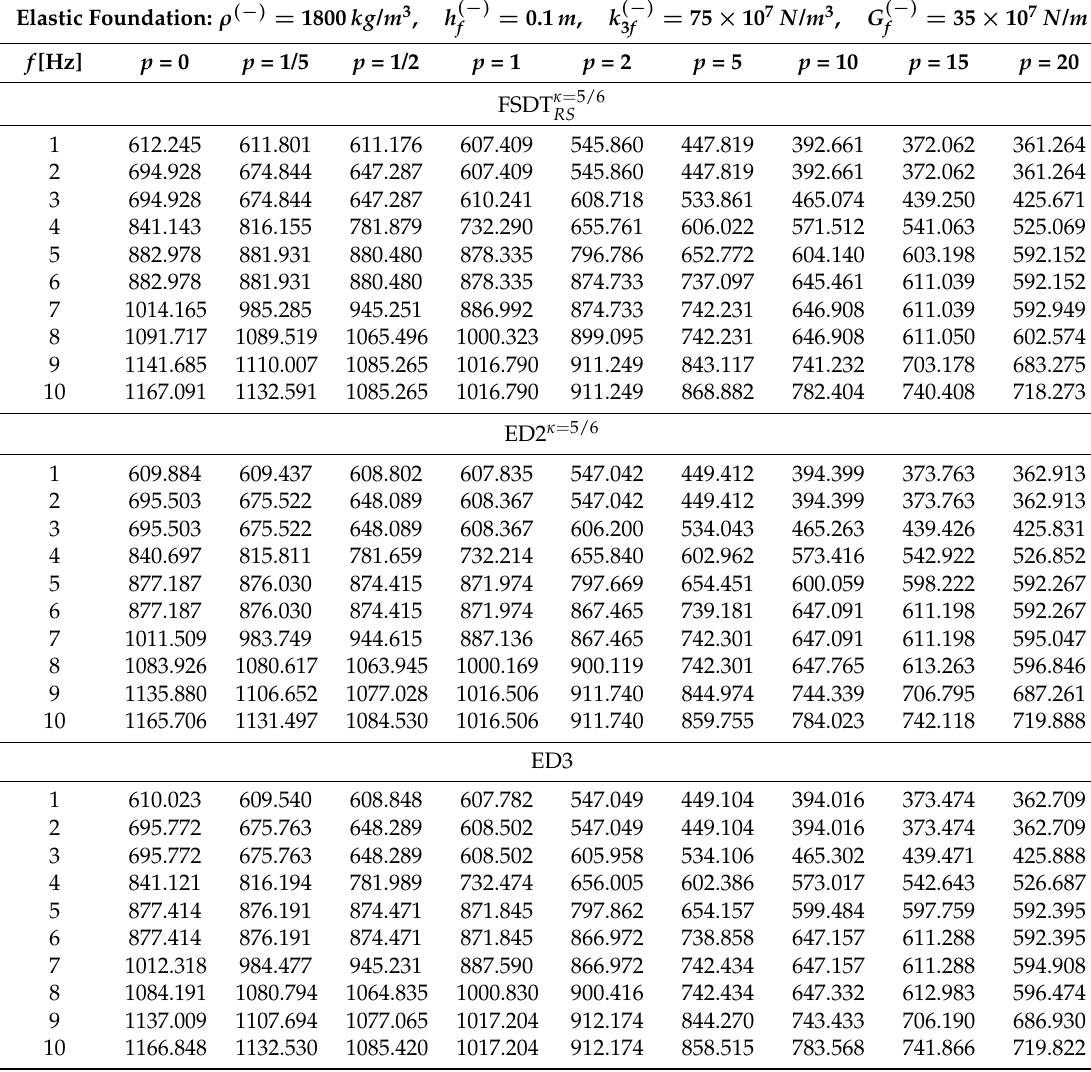
Table 5. First ten natural frequency variations of a CCCC square plate (Figure 4a) made of one lamina of constant thickness h = 0.1m reinforced by CNTs distributed as in Figure 5a for the different parameters p ( 1 ) = p . The mass fraction was w r = 0.05 and the agglomeration parameters µ 1 = µ 2 =